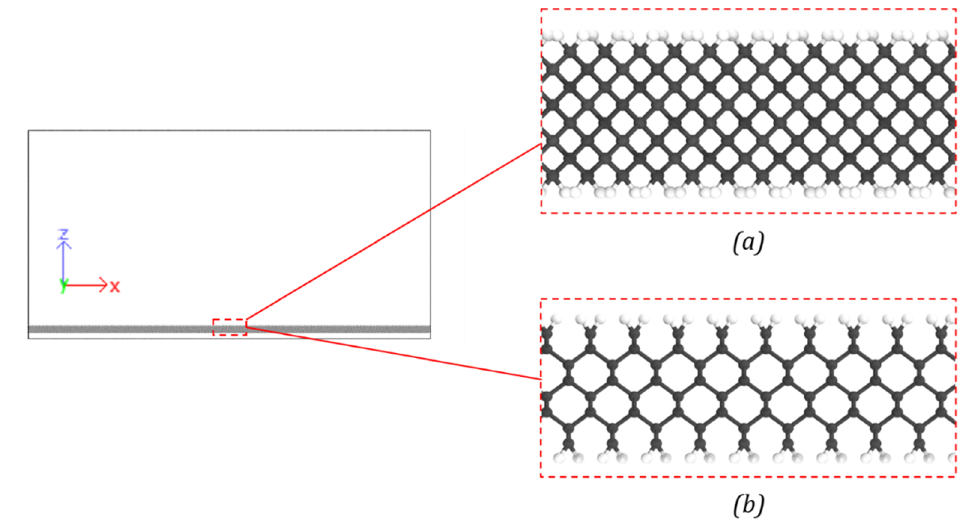
Figure 10. Aliphatic surface model with valency-terminated hydrogen atoms ( a ) enlarged view of the aliphatic carbon surface with valency terminated hydrogen atoms in XZ plane ( b ) enlarged the view of aliphatic carbon surface with valency terminated hydrogen atoms in the XY plane.